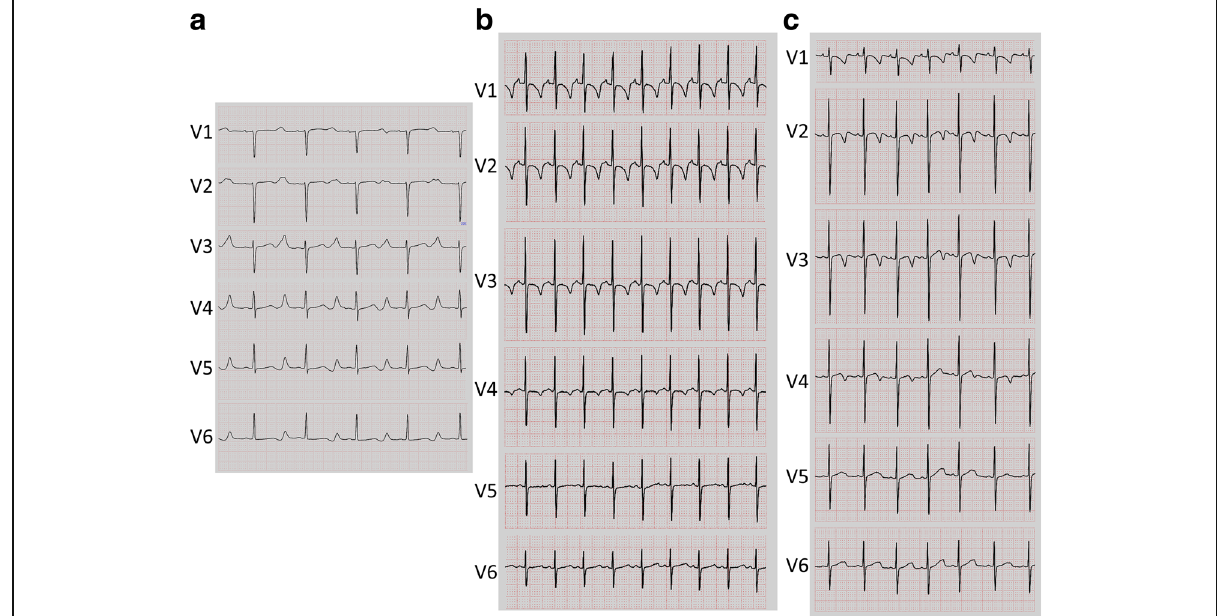
Fig. 3 Baseline electrocardiogram (ECG) of the proband (II-2), her son (III-1), and her daughter (III-2). Baseline ECG from the proband at 44 years of age a , baseline ECG from the son at 8 months of age b , and baseline ECG from the daughter at 5.25 years old c . Baseline ECG from the proband a was recorded under beta-blockers (atenolol and bisoprolol) and other medication (mexiletine). Baseline ECGs from the children b , c were recorded under beta-blocker treatment